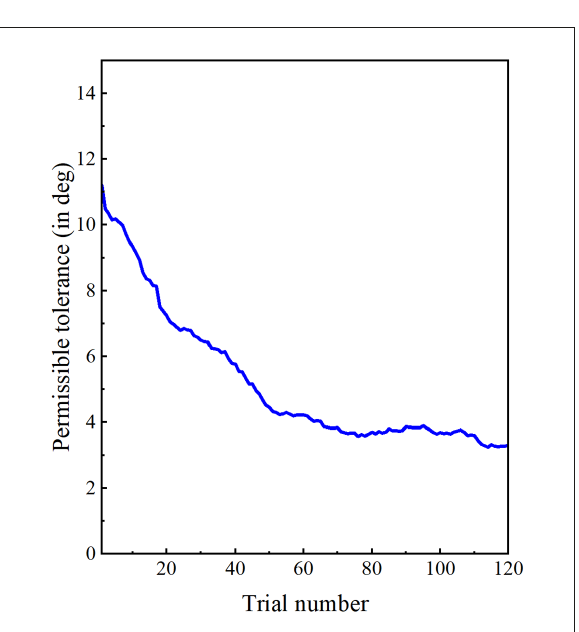
FIGURE4 Permissible tolerance: Permissible tolerance value is computed using an adaptive algorithm. The tolerance value decreased during the training phase based on the performance of the participants.